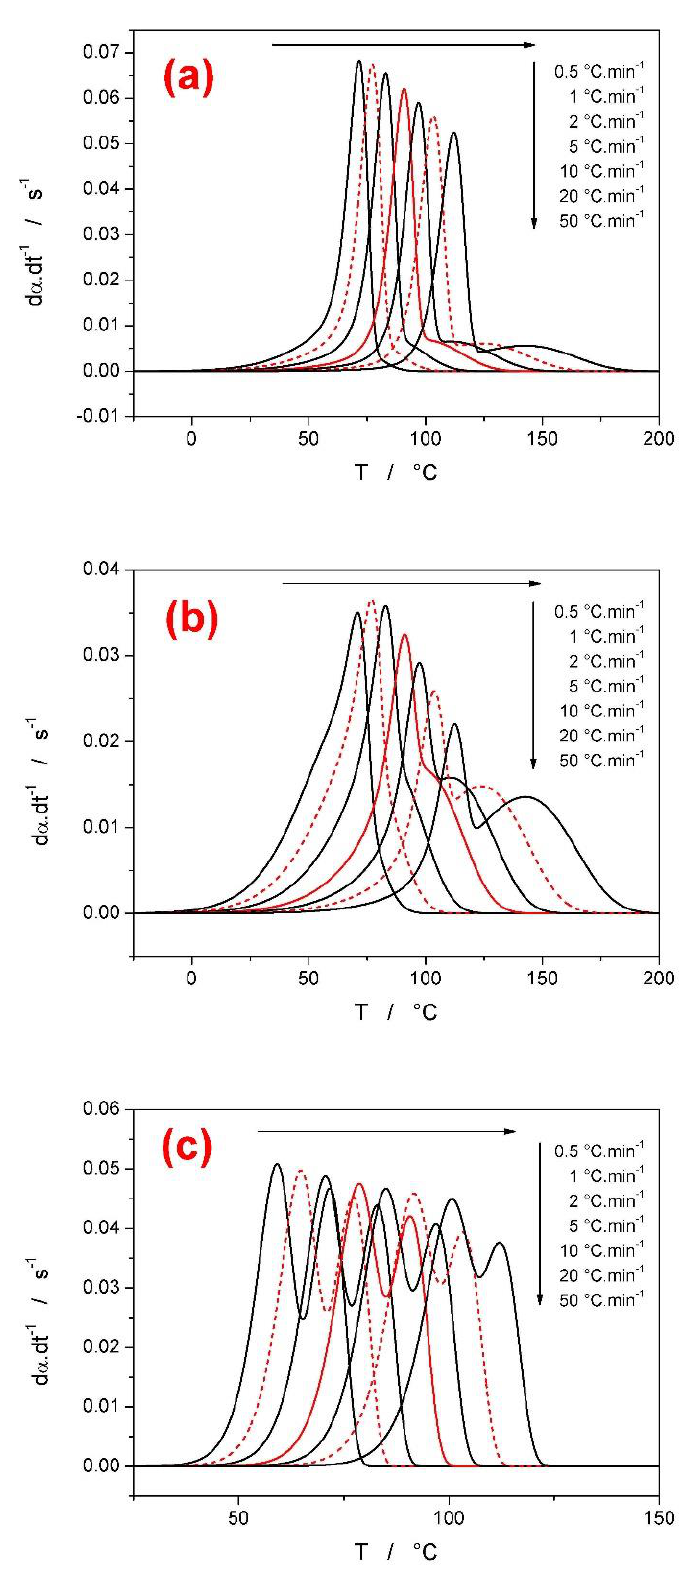
Figure 1. First sub-group of base sets of simulated data; the simulations were performed with 10,000 points / curve density. The kinetic parameters are listed in Table 1. Each graph depicts set of seven complex kinetic curves simulated for the heating rates 0.5, 1, 2, 5, 10, 20, and 50 ◦ C · min − 1 . ( a ) set A; ( b ) set B; ( c ) set C.